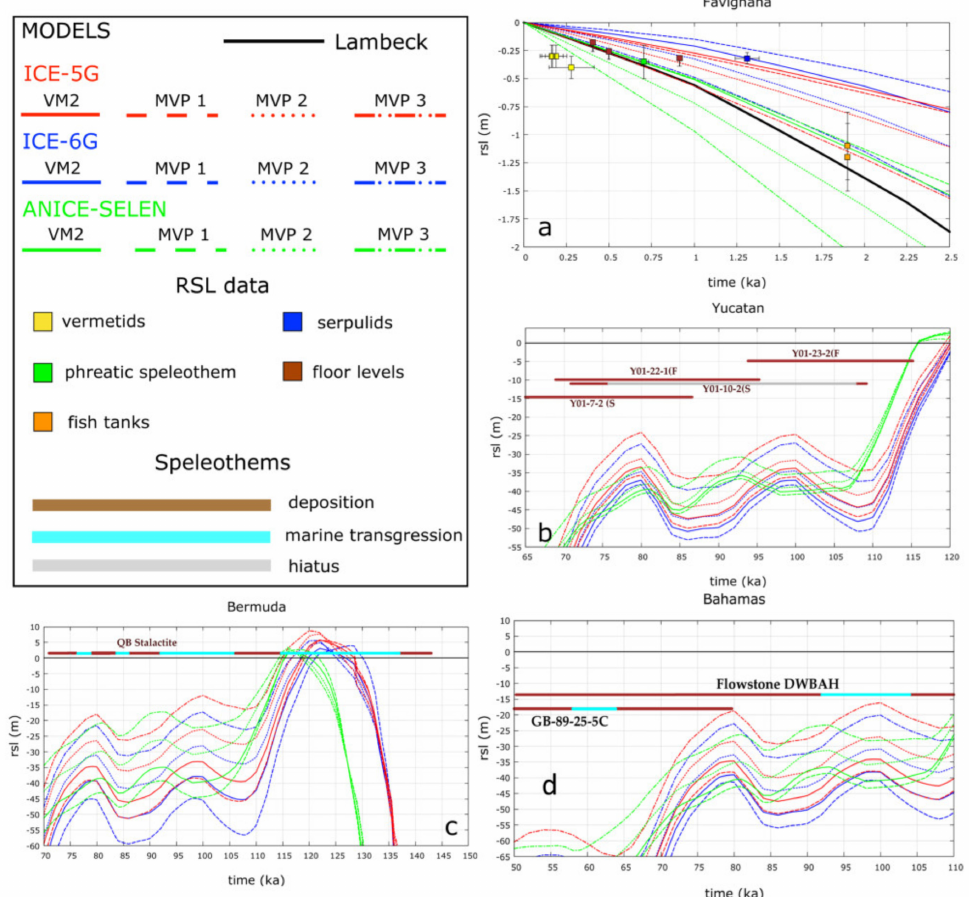
Figure 10. Predicted RSL curves for the ICE-5G (red curves), ICE-6G (green curves), and ANICE- SELEN (blue curves) ice-sheet models in combination with MVP 1–3 mantle viscosity profiles (solid, dashed and dotted lines, respectively) at each site and with respect to the measured